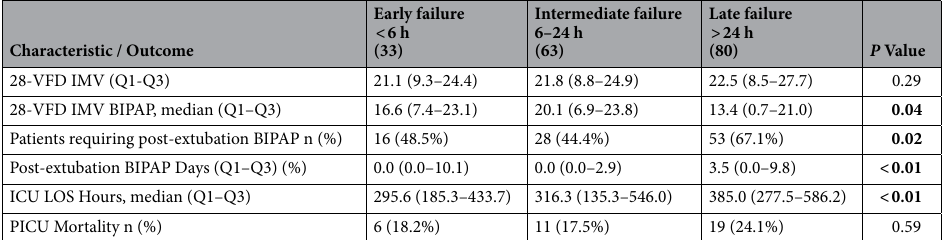
Table 2. Outcomes parsed by hours between BIPAP initiation and BIPAP failure ( P values from Kruskal– Wallis H-test). Significant values are in bold.